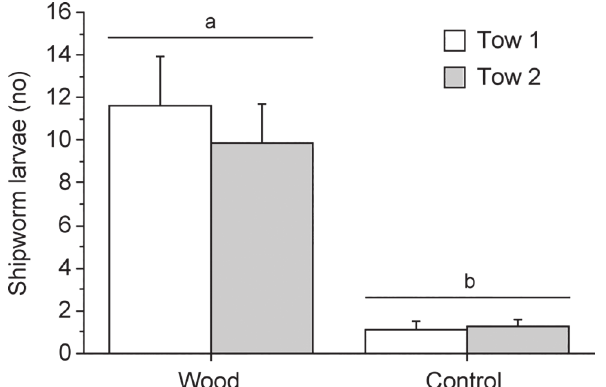
Fig 2. Field experiment. Number of shipworm larvae collected around wooden panels wrapped in plankton net (Wood) or plankton net only (Controls) at two occasions (Tow 1 and 2). Letters above bars indicate significant differences between mean values based on the Student-Newman-Keuls multiple comparisons test (SNK, P < 0.05). Error bars show + SEM (n = 8).